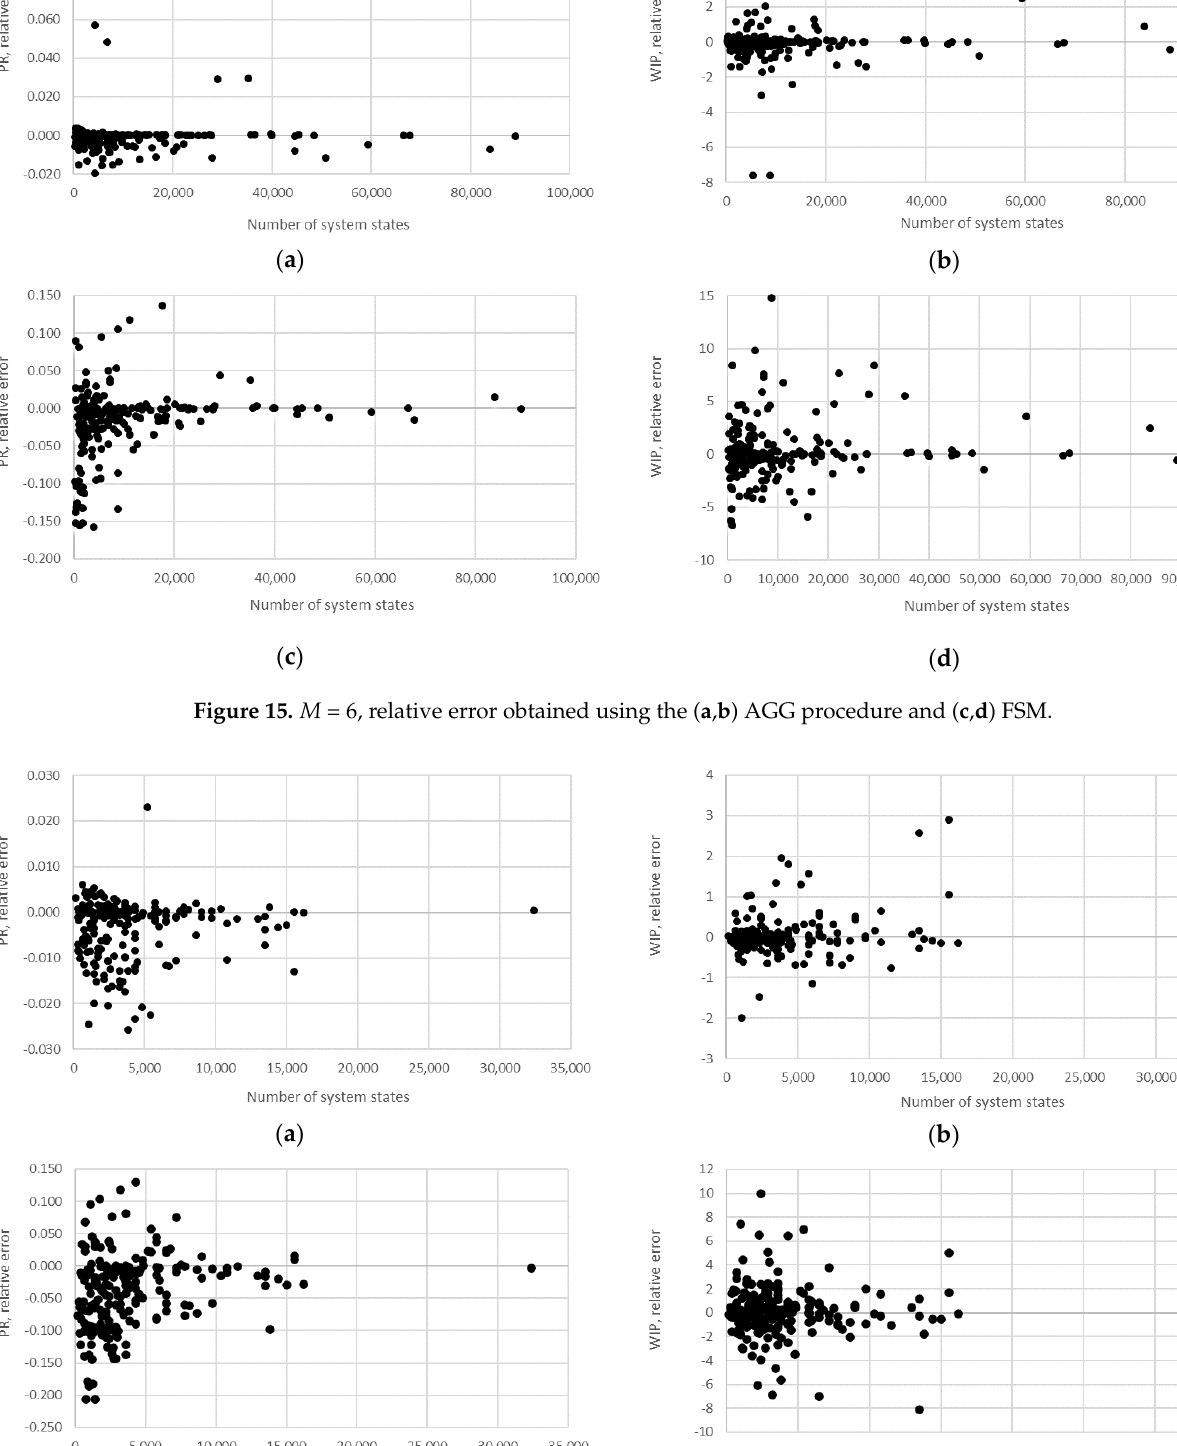
Figure 16. M = 7, relative error obtained using the ( a , b ) AGG procedure and ( c , d ) FSM.